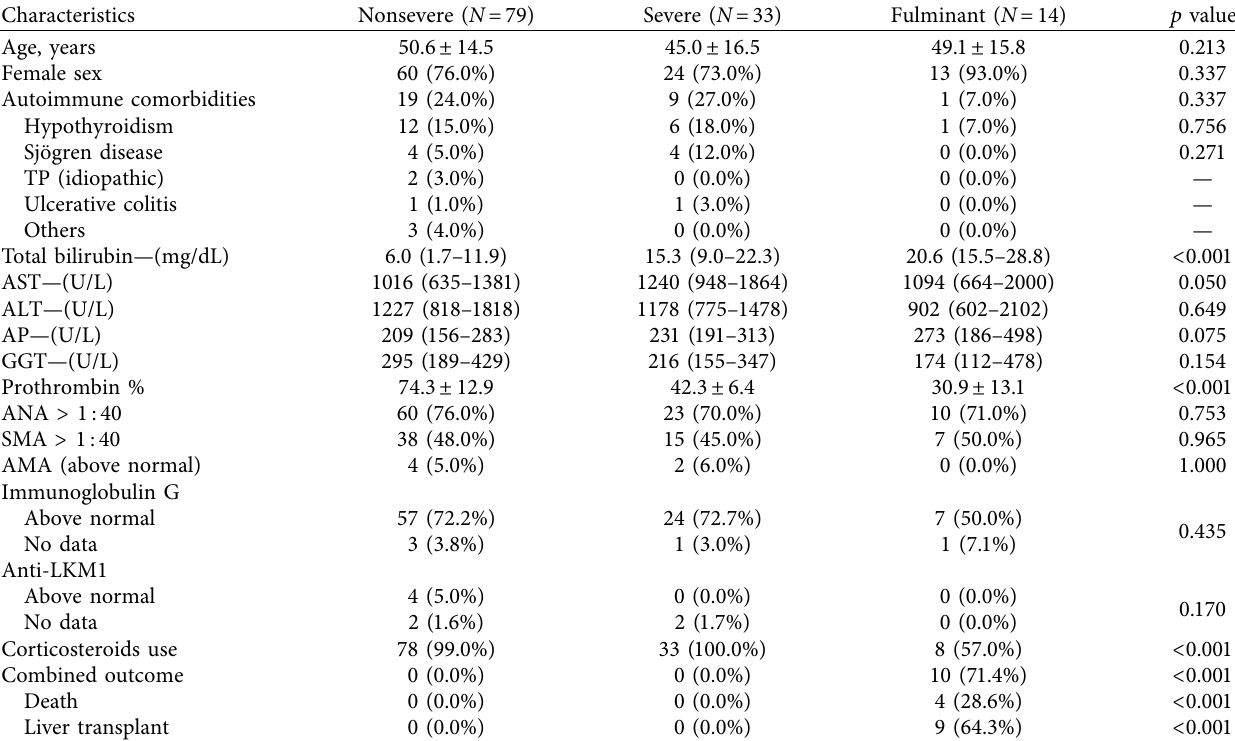
Table 1: Basal characteristics of the patients according to disease severity.